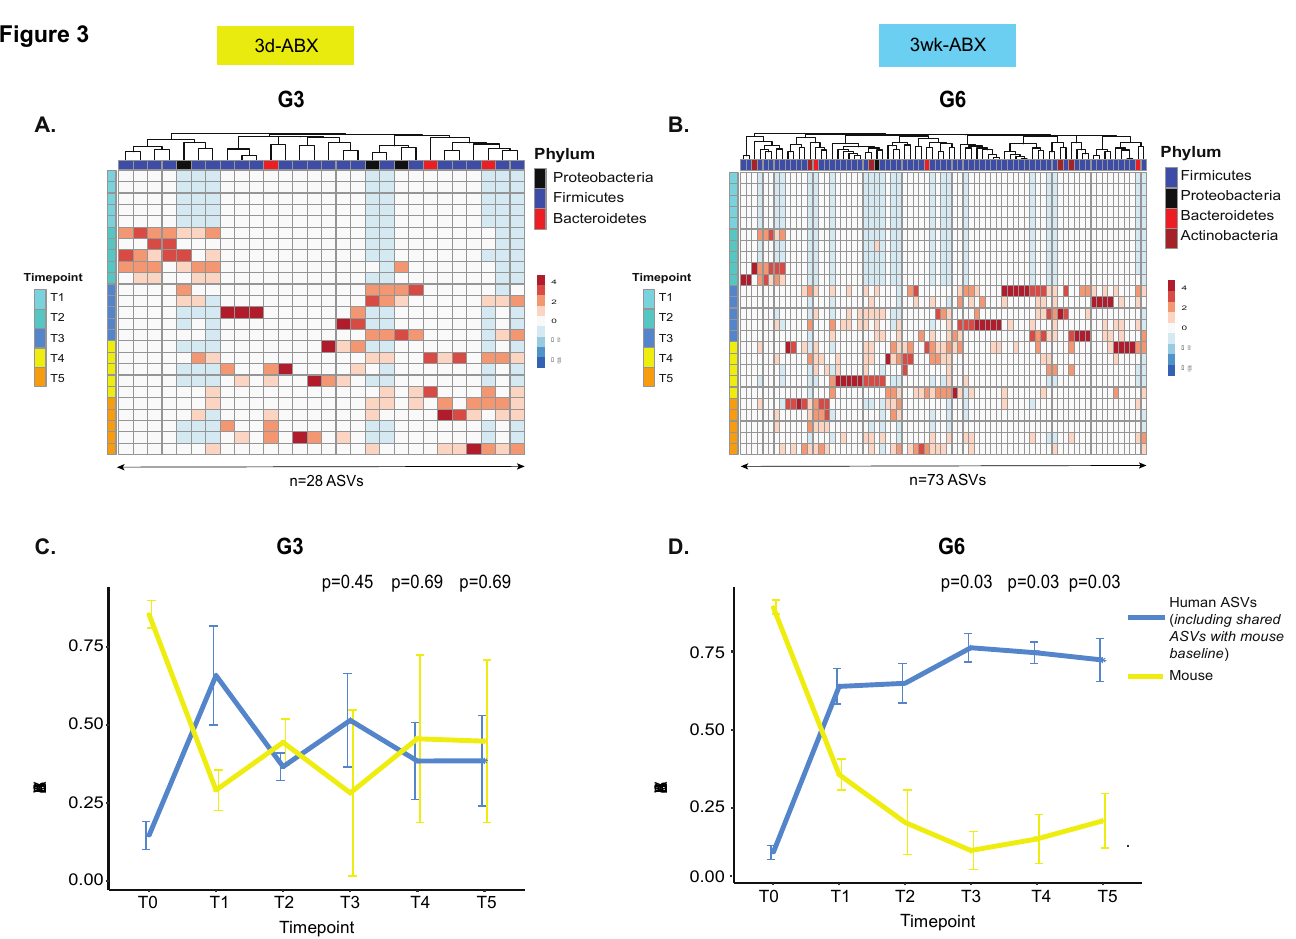
Figure 3. Comparison of engraftment kinetics. Unsupervised hierarchical clustering heatmap of ASVs uniquely identified in the input FMT material in ( A ) G3 and ( B ) G6 mice ( n = 5 mice/group). Columns represent ASVs. Rows are samples temporally arranged from T1 through T5. Line plot to compare changes in ‘human’ and ‘mouse’ ASV abundances over time in ( C ) G3 and ( D ) G6 mice ( n = 5 mice/group). The mean and standard deviation of ASV abundances is represented at each time point. The p -value is calculated from a one-sided paired Wilcoxon signed-rank test and adjusted for false discovery rate [36]. Other groups in Figure S5. Additionally, see line plot for ASVs uniquely derived from input material in Figure S6.